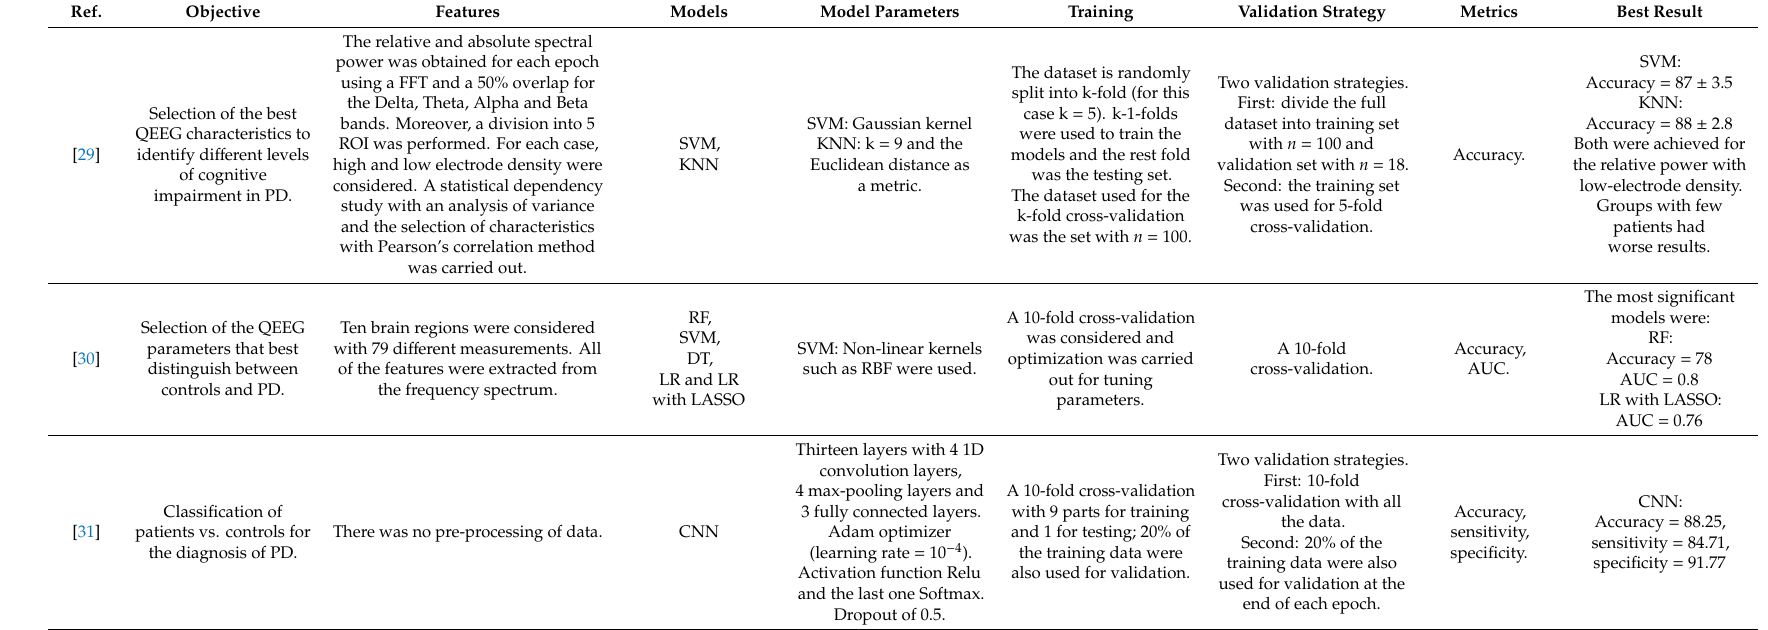
Table 3. Summary of the model parameters, such as features extracted, models used, model architecture, training and validation methods, results and metric used for the articles included in this review. The columns with the references and objectives of the selected articles are included again for the sake of readability.